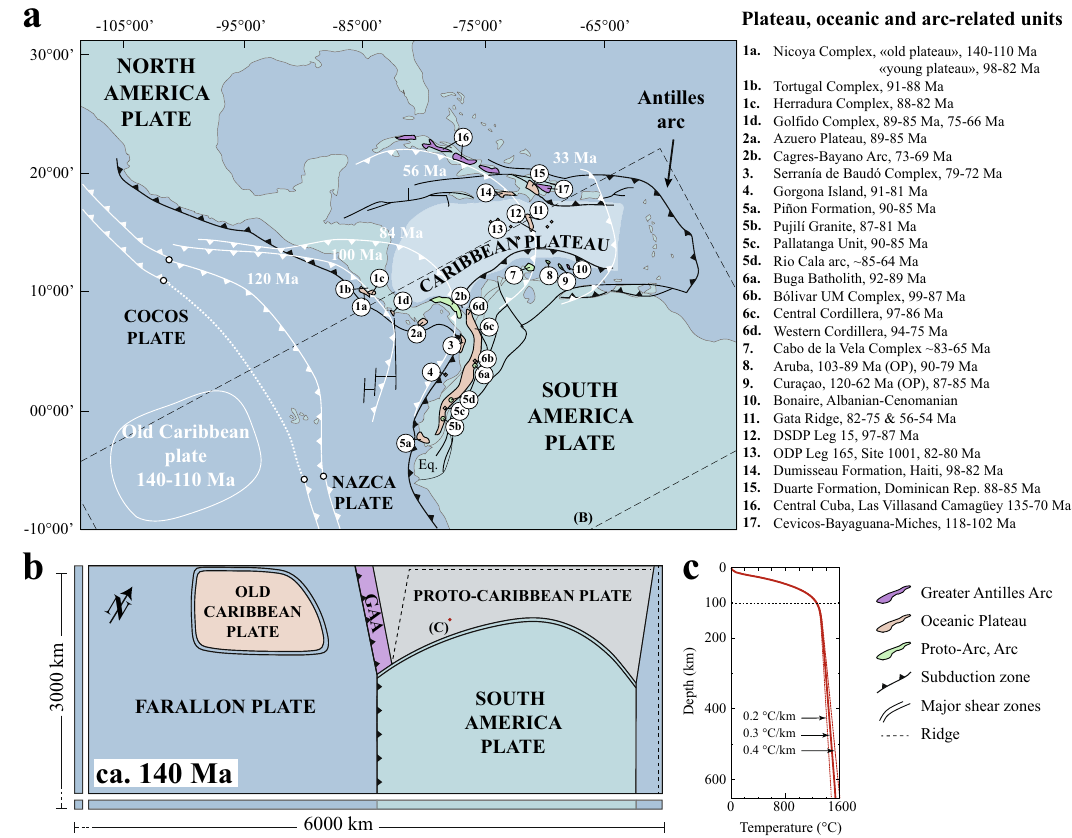
b map view of the reference model setup. c initial temperature pro fi le. Heavy line: reference initial temperature gradient of 0.3 ∘ C/km for the upper mantle. Dashed lines, other investigated initial upper mantle temperature gradients (0.2 and 0.4 ∘